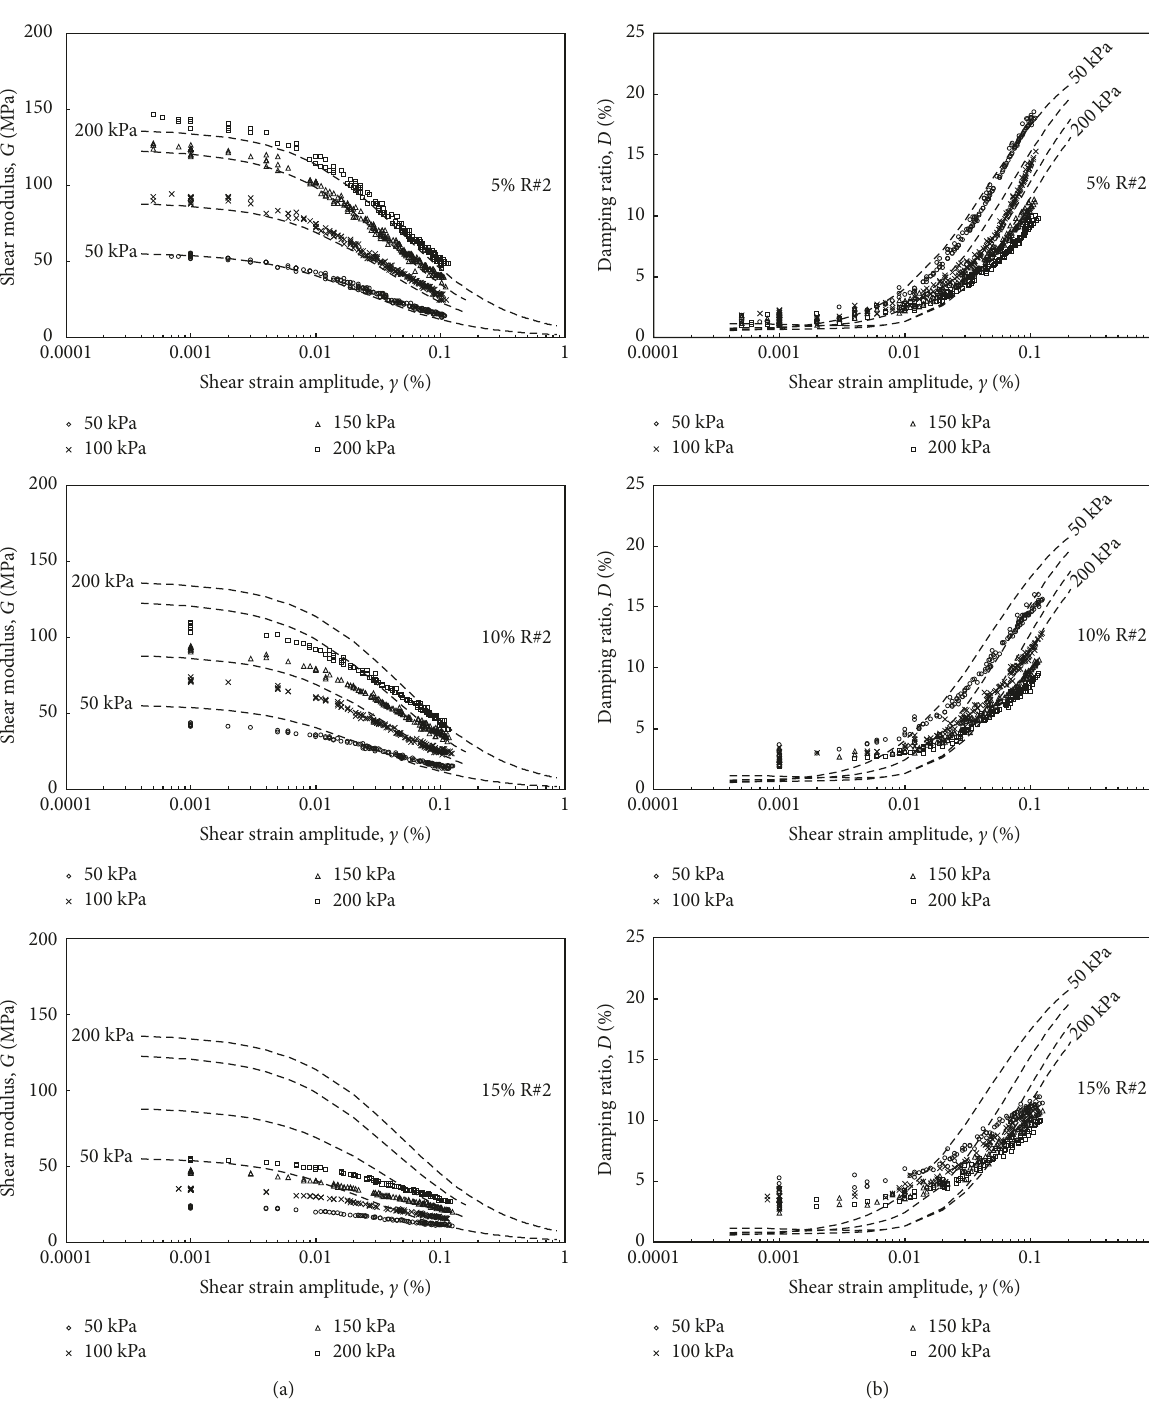
Figure 8: R#2 sand mixture: (a) strain-dependent shear modulus and (b) strain-dependent damping